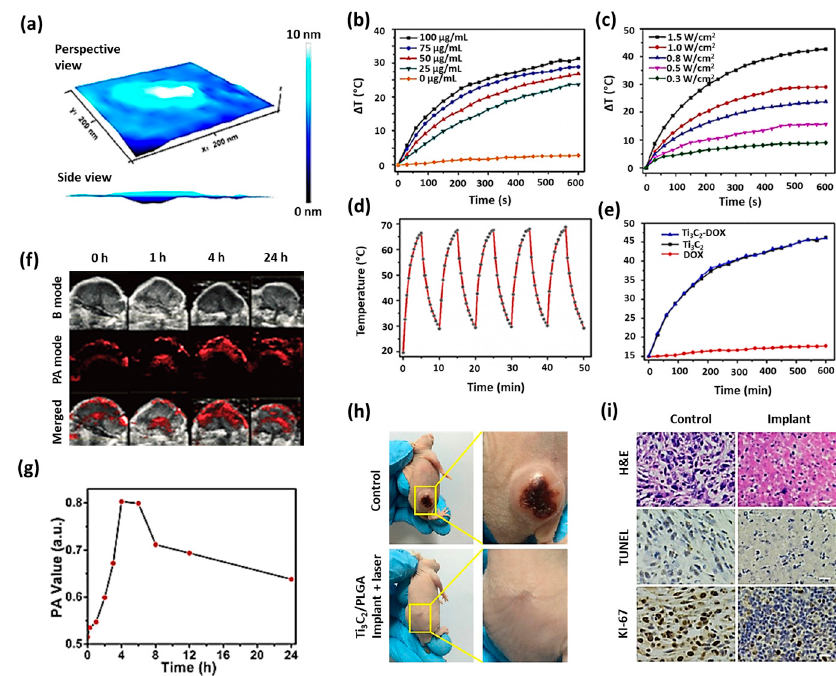
Figure 2. ( a ) 3D AFM image of Ti 3 C 2 nanosheets. ( b ) Photothermal profile of Ti 3 C 2 nanosheets in water. Adapted with permission from [81]. ( b ) at various concentrations of 0–100 µ g / mL under irradiation (808 nm and 1.0 W / cm 2 ) and ( c ) under di ff erent laser power densities of 0.3–1.5 W / cm 2 at concentration of 50 µ g / mL. ( d ) Photostability test performed in a solution containing Ti 3 C 2